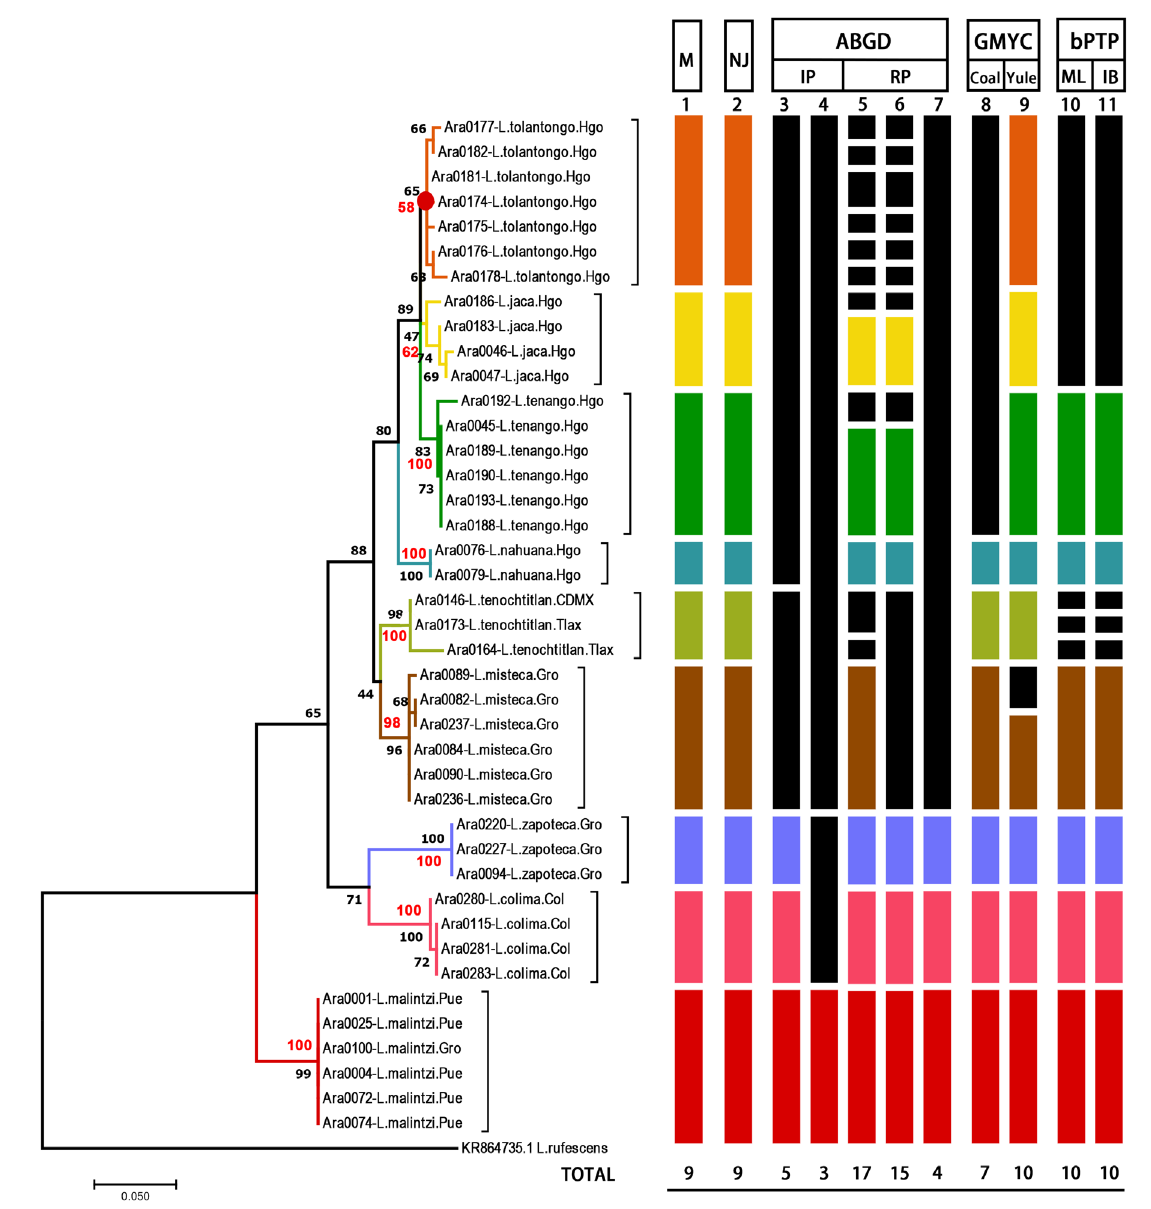
Fig. 55. Maximum likelihood tree inferred from ITS2 gene of species of Loxosceles Heineken & Lowe, 1832 from Mexico. Colors of branches and bars indicate different species. Numbers above bars represent the delimitation methods: 1 = morphology (M); 2 = neighbor joining (NJ); 3–4 = ABGD with initial partitions (IP); 5–7 = ABGD with recursive partitions (RP); 8 = GMYC yule analysis; 9 = GMYC coalescent analysis; 10 = bPTP with ML; 11 = bPTP with IB. Numbers below bars represent species recovered for each delimitation method. Red numbers on branches correspond to Bayesian posterior probabilities, black numbers are bootstrap support values from the ML